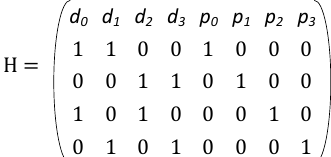
Figure 4. Parity check matrix of a (8, 4) orthogonal Latin square code.